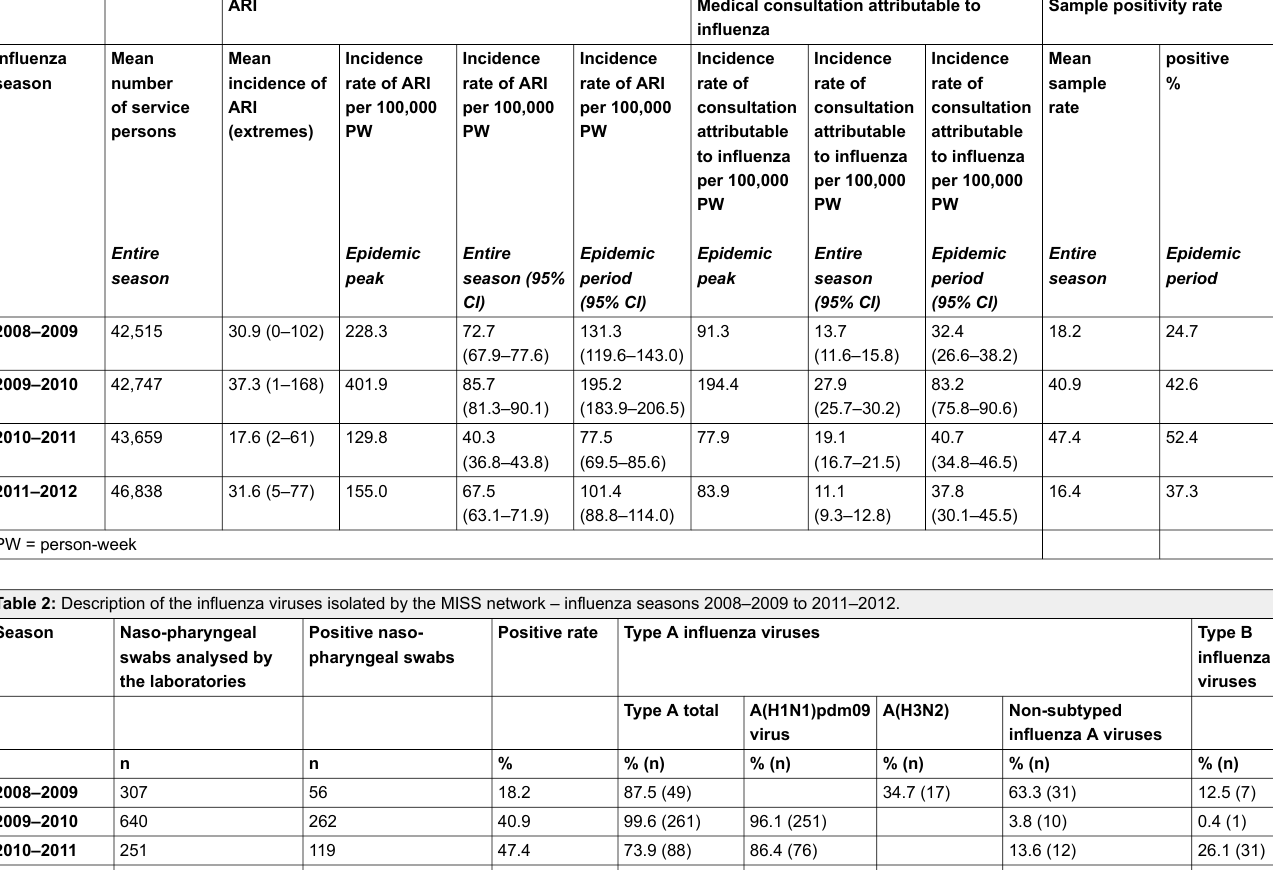
Table 1: Description of the main indicators monitored by the MISS and incidence rates of acute respiratory infection (ARI) and of medical consultation attributable to influenza (entire season and epidemic period) – influenza seasons 2008–2009 to 2011–2012. ARI